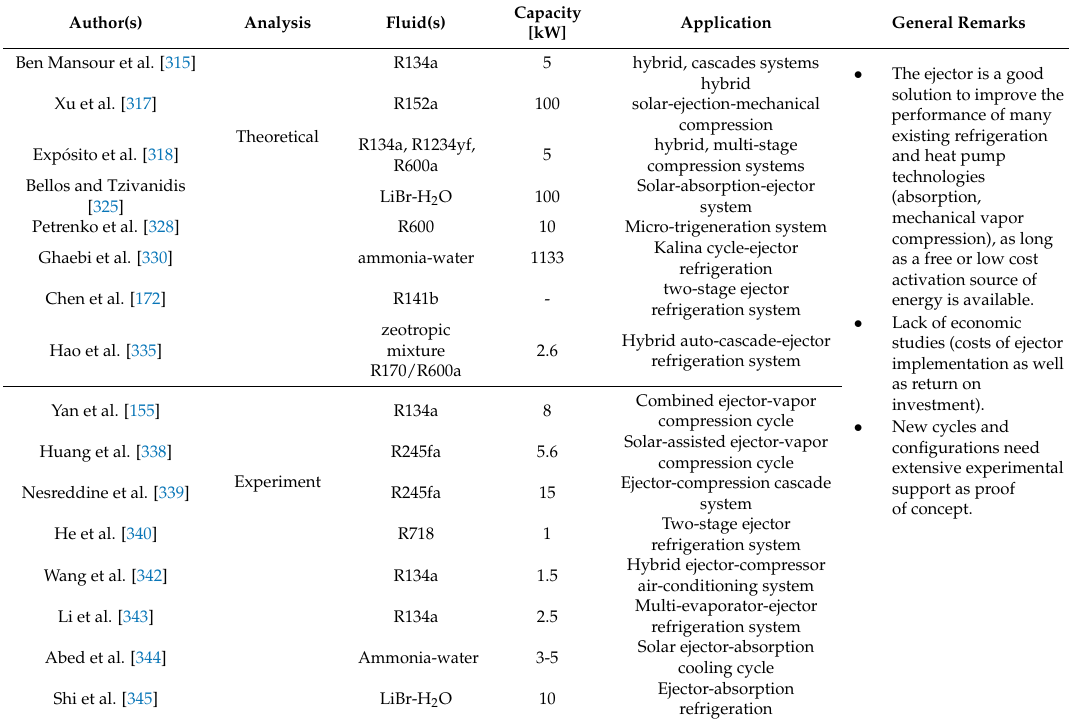
Table 7. Ejector-boosted conventional